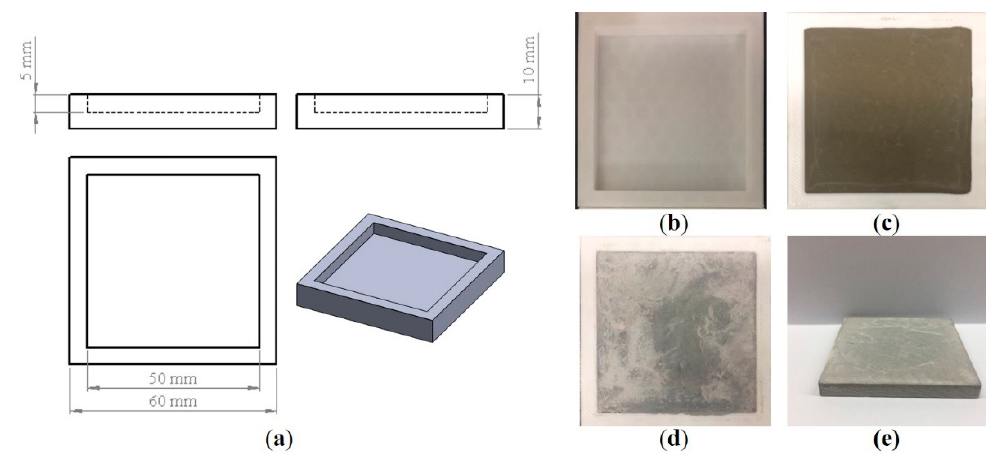
Figure 2. Schematic of the ( a ) three views of the cement mold, ( b ) real product of cement mold, ( c ) the fresh cement paste in the mold, ( d ) hardened cement paste in the mold, and ( e ) cement paste after 1 day of curing and demolding.